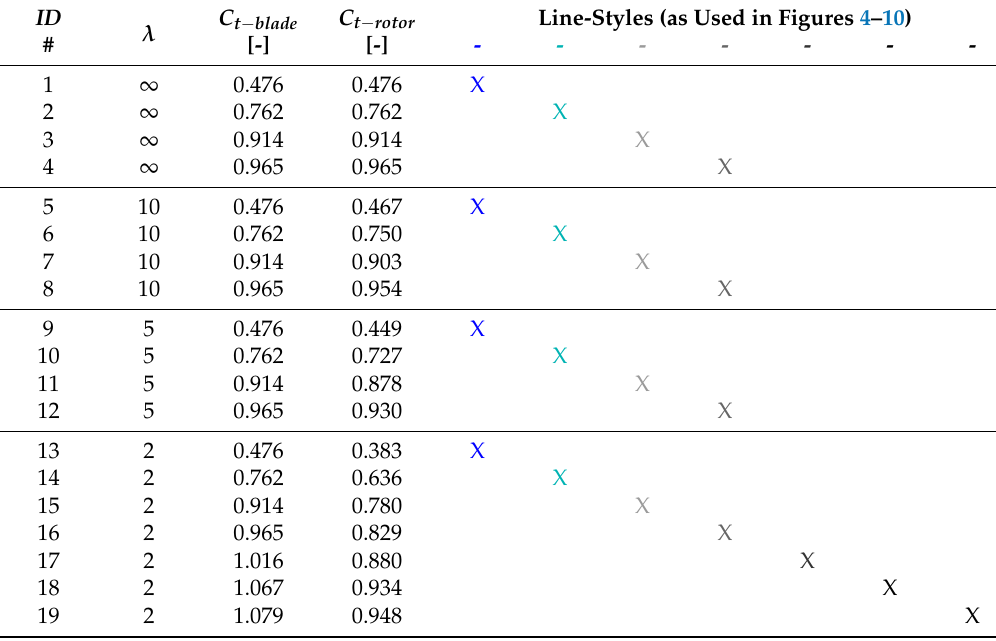
Table 1. Overview of AD